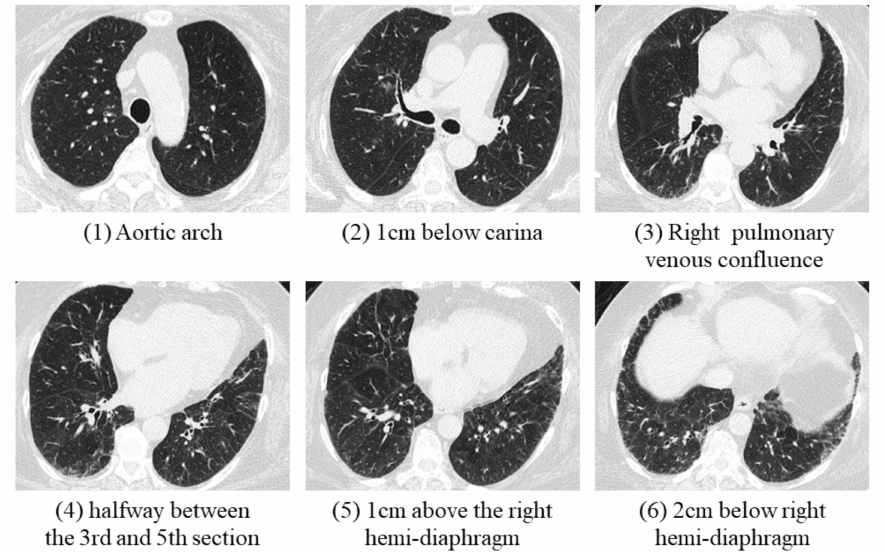
Figure 1. A 69-year-old female was diagnosed with IPF with probable UIP pattern in an MDD meeting. The percentage of fibrosis was calculated in these six levels, and the fibrotic score was calculated as the average percentage of these six